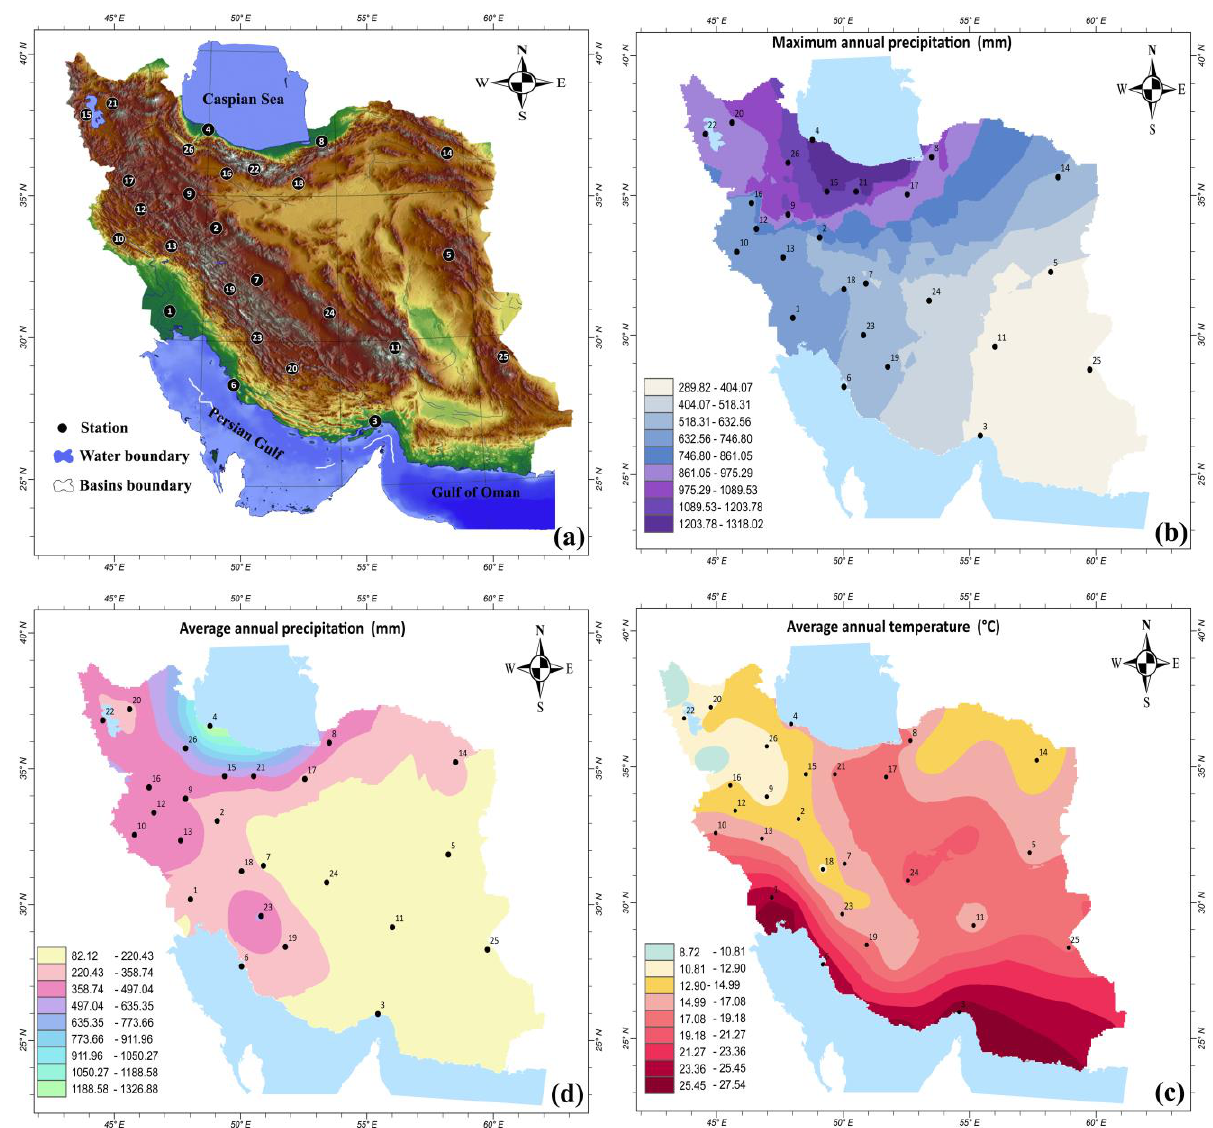
Figure 1. ( a ) Topographic map of Iran and the geographical locations of the selected stations, and spatial distributions of ( b ) the maximum annual precipitation, ( c ) average annual precipitation, and ( d ) average annual air temperature over Iran. Table 1. Geographical characteristics and location of the selected stations.